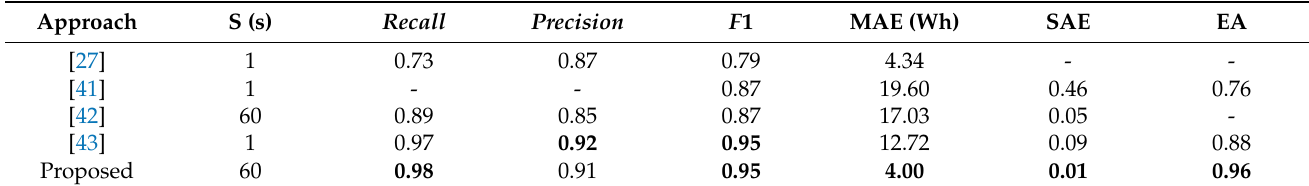
Table 17. Fridge performance comparison.